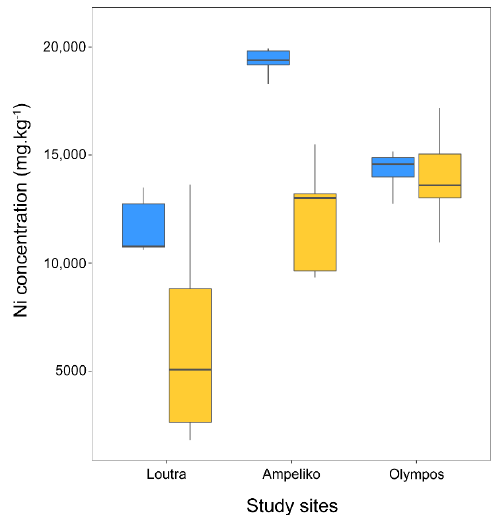
Figure 3. Leaf Ni concentration (mg.kg − 1 ) of healthy (blue boxplots) and infected (yellow boxplots) Odontarrhena lesbiaca individuals from three serpentine sites (Loutra, Ampeliko, Olympos) in the island of Lesbos, Greece. The central horizontal line in the box plots represents the median of the samples; the box plot edges represent the first and third quartile. The interquartile range (IQR) within the boxes present the central 50% of the values. The whiskers show the range of observed values and the locations of the minimum and the maximum values.